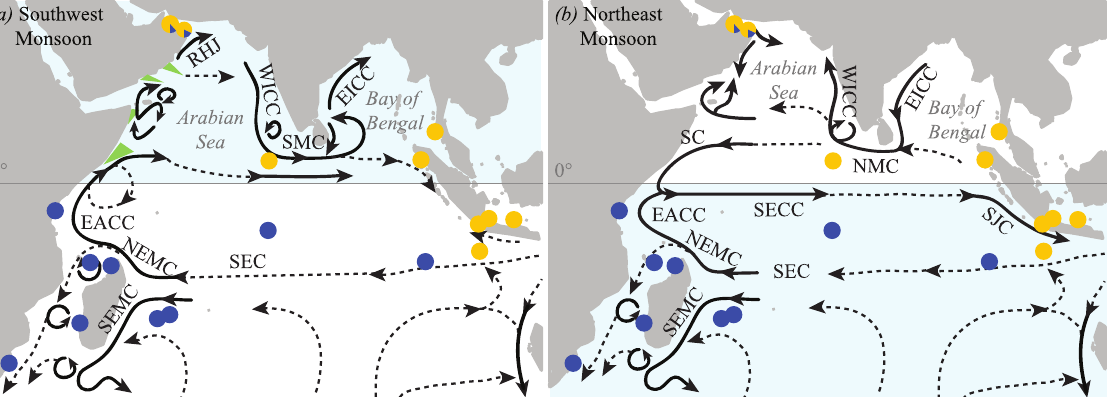
Figure 3. Schematic representation of the Indian Ocean surface circulation. (a) During the southwest (July/August) and (b) northeast (December/January) monsoon after Schott and McCreary [67], in relation to crown-of-thorns starfish sampling locations (yellow circles: NIO sister- species, blue circles: SIO sister-species). Blue shaded areas indicate the area in which COTS larvae would likely be released according to season. Green wedges in (a) are upwelling areas. Current branches indicated are the South Equatorial Current (SEC), Southeast and Northeast Madagascar Current (SEMC and NEMC), East African Coast Current (EACC), Somali Current (SC), Ras al Hadd Jet (RHJ), West and East Indian Coast Current (WICC and EICC), Southwest and Northeast Monsoon Current (SMC and NMC), South Java Current